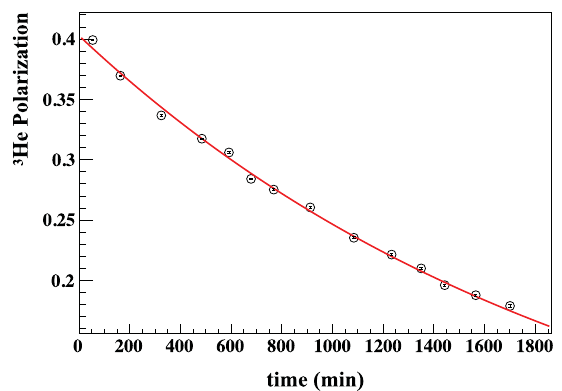
Figure 5. Relaxation of the 3 He polarization as a function of time, derived from NMR measurements. The spin of the 3 He is flipped between each